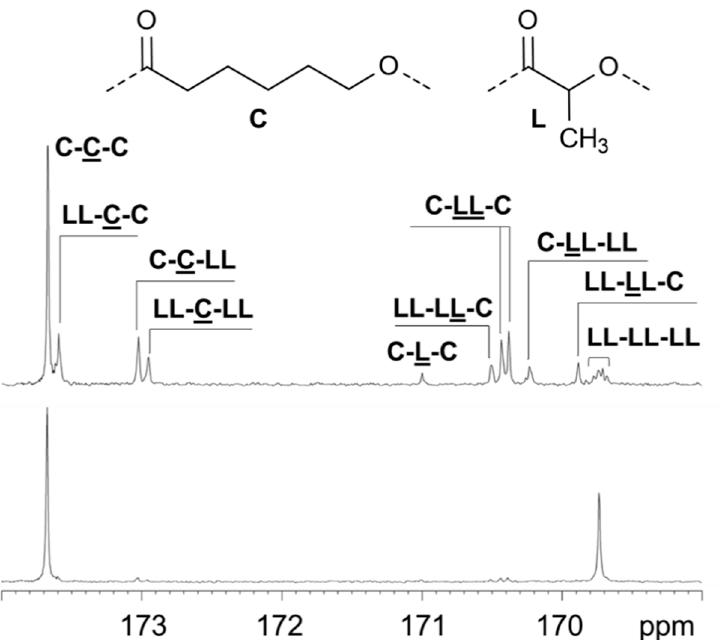
Figure 3. Carbonyl regions of the 13 C NMR spectra of: (top) poly-(L-Lactide- co - ε -caprolactone) and (bottom) poly-(L-lactide- block - ε -caprolactone) (CDCl3, 25 °C, 600 MHz).